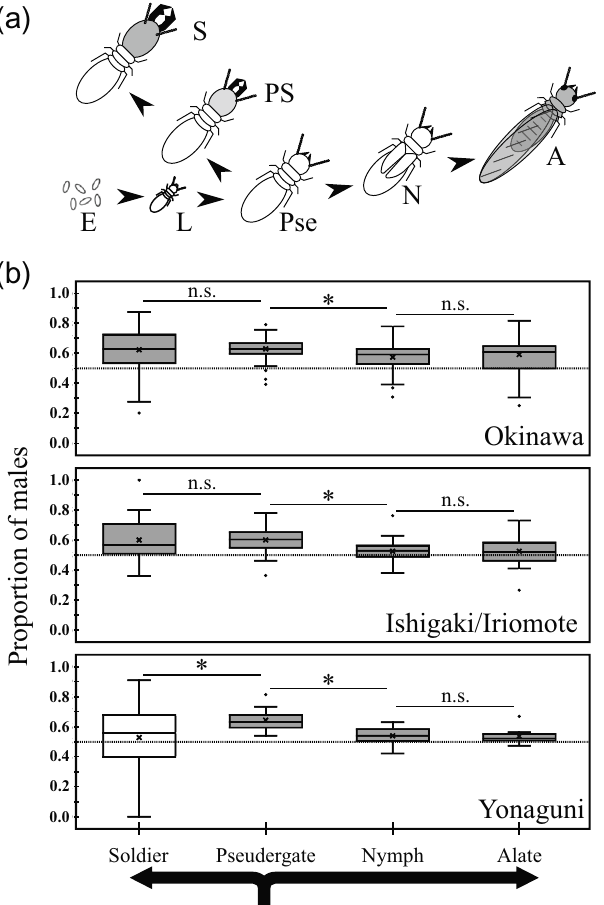
Figure 1. Relationship between caste developmental pathway and numerical sex ratios in the three populations. ( a ) The caste developmental pathway of Neotermes sugioi 26 . E egg, L larva, Pse pseudergates, PS pre- soldier, S soldier, N nymph, A alate. ( b ) Comparisons of numerical sex ratios between castes. In each box, the cross symbol indicates the mean, bar in the box indicates the median, and the box top and bottom indicate the first and third quartiles, respectively. The asterisk next to each bar between boxes indicates p < 0.05 (glmm analysis with sequential Bonferroni), and "n.s." indicates “not significant”, i.e., p ≥ 0.05. The gray boxes indicate deviations from equal sex ratios at p < 0.05 (Wald tests in glm analysis with sequential Bonferroni), and the white boxes indicate p ≥